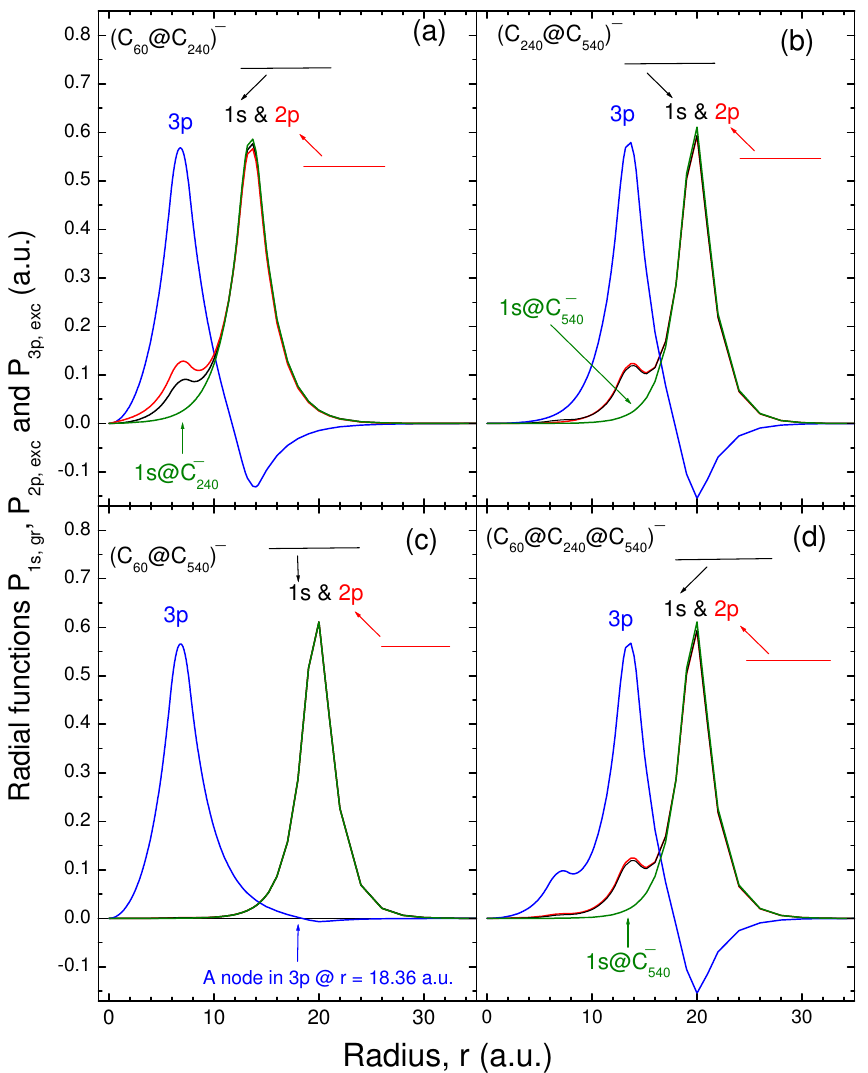
Figure 3. Calculated radial ground-state P 1 s ( r ) and excited-state P 2 p and P 3 p (due to the 1 s → np transitions, n = 2, 3) of the attached electron in fullerene onion-anions: ( a ) ( C 60 @C 240 ) − , ( b ) ( C ) − , ( c ) ( C ) − , ( d ) ( C ) − : solid, P 60 @C 540 60 @C 240 @C 540 2 p ; dashed, P 1 s ; dash–dot, P 3 p . Also 240 @C 540 plotted are the P 1 s (dash–dot–dot) functions in bare C − and C − , as designated, for comparison 240 540 purposes. Note, to avoid any confusion, that the graphs for the P 1 s and P 2 p functions in the fullerene onion-anions tightly overlap with each other and are practically indistinguishable from each other with some exception in the case of ( C 60 @C 240 ) −